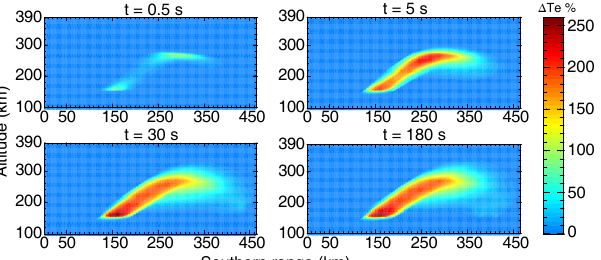
Figure 7. The evolution of the ionospheric electron temperature changes in the center meridian plane with heating wave incidence perpendicular to the magnetic field line at different heating duration